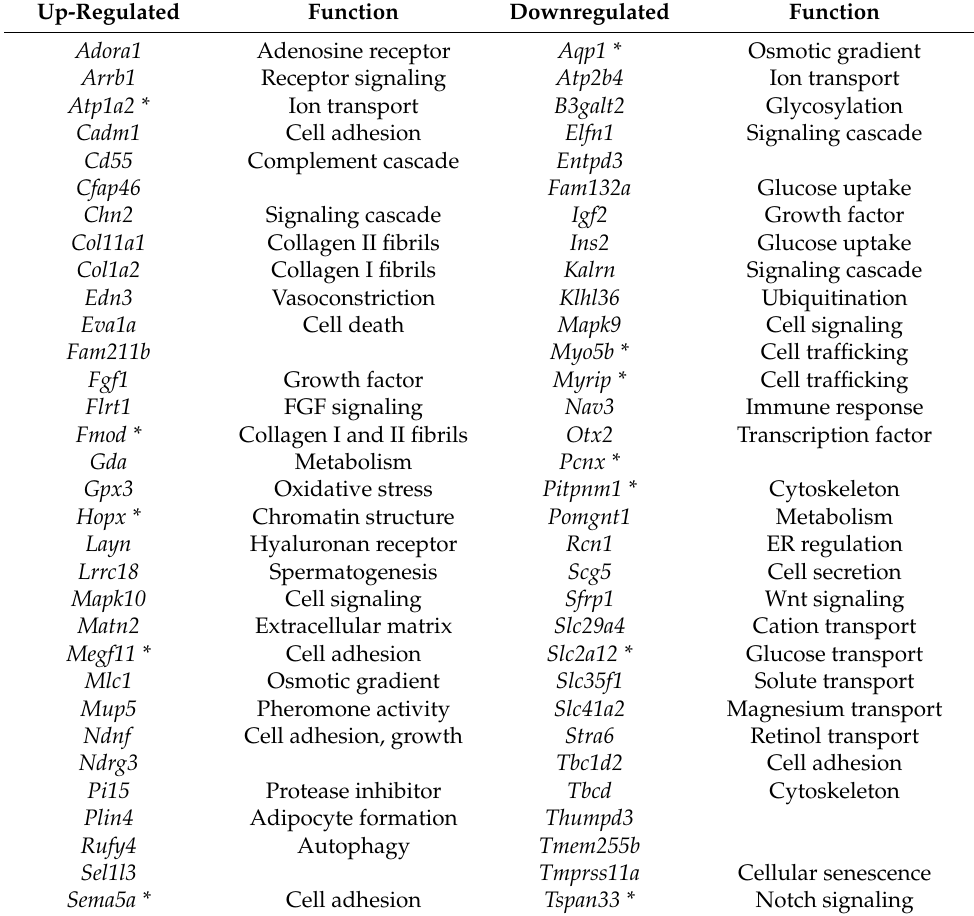
Table 3. Choroid plexus genes with significant expression changes in both Otx2 knockdown models, including lateral ventricle and fourth ventricle from Cre + Otx2 lox/lox mice and fourth ventricle from Otx2 +/GFP mice. Genes with * are also deregulated upon embryonic Otx2 knockdown in the hindbrain choroid plexus